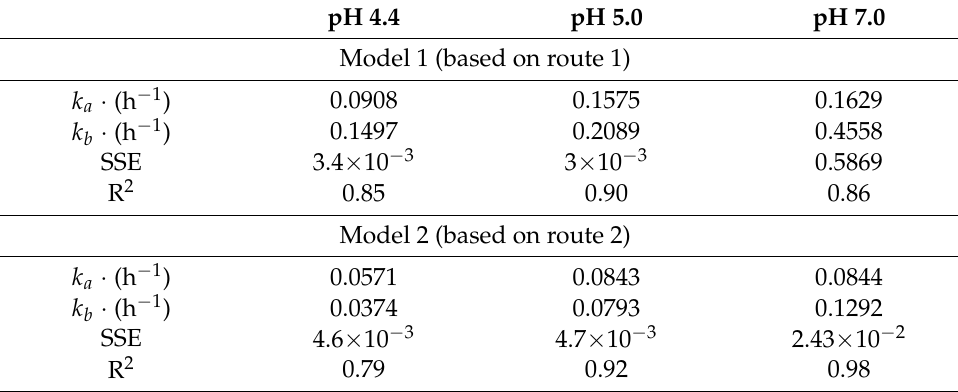
Table 5. Kinetic constants for EC at various initial